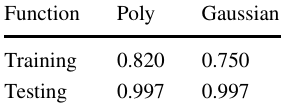
Fig. 25 Correlation between the actual and the predicted choke size for testing data (FN) ( R = 0.81) Table 11 Correlation coefficient summary for the different